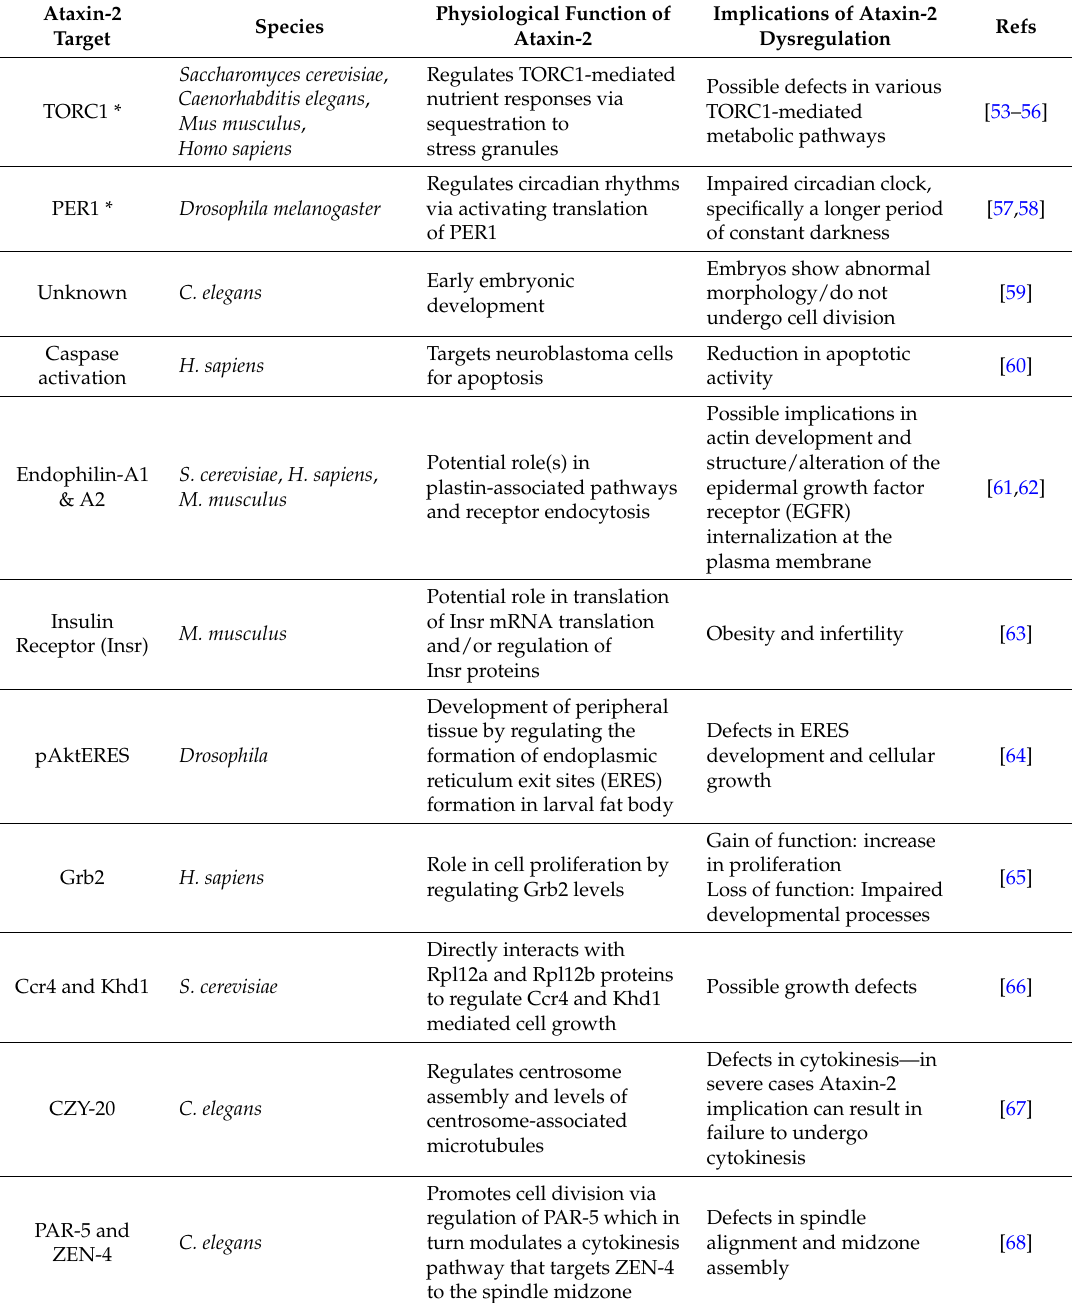
Table 1. Functions of Ataxin-2 in various physiological